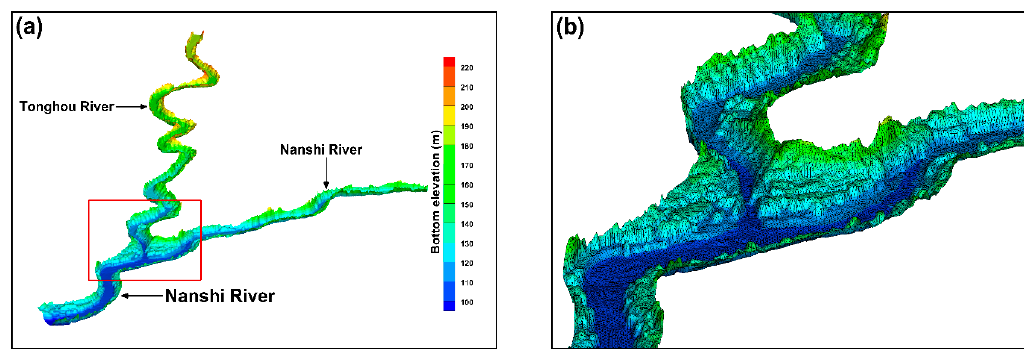
Figure 6. 3D view of the bottom elevations of the hydrodynamic model ( a ) and an enlargement of the junction of the Nanshi and Tonghou Rivers with high-resolution triangular meshes ( b ).